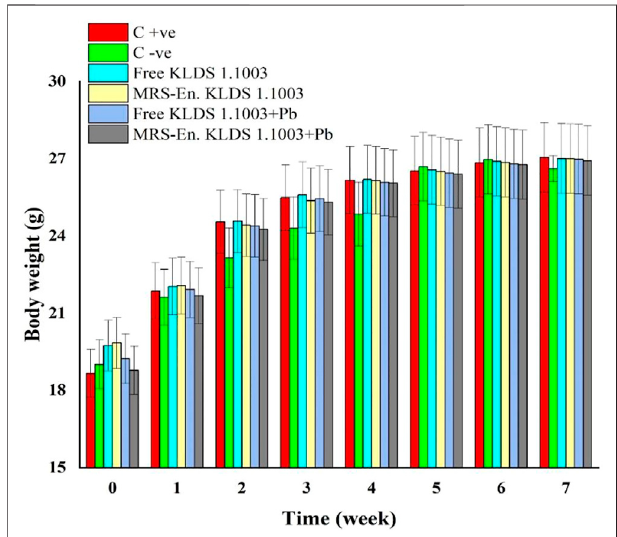
FIGURE5| AssessmentofthefreeandMRS-basedmicroencapsulated L. acidophilus 1.1003 on mice ’ s body weights with lead fed in drinking water throughout the experimentation period of 7-weeks. Values aremean ± standard deviation